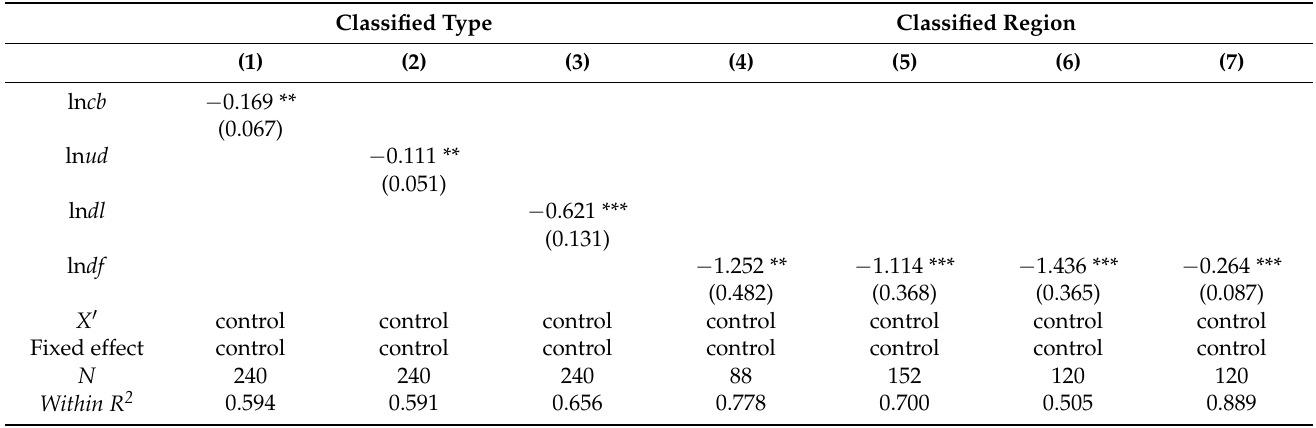
Table 2. Heterogeneity test of the impact of digital finance on green